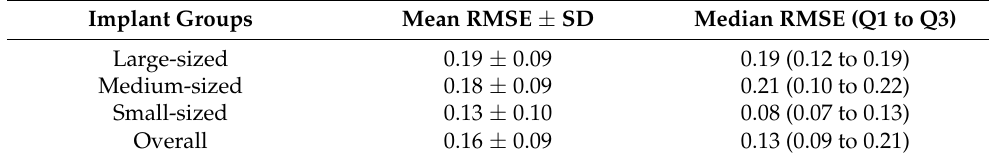
Table 1. Average deviation values (in mm) for each group. Implant Groups